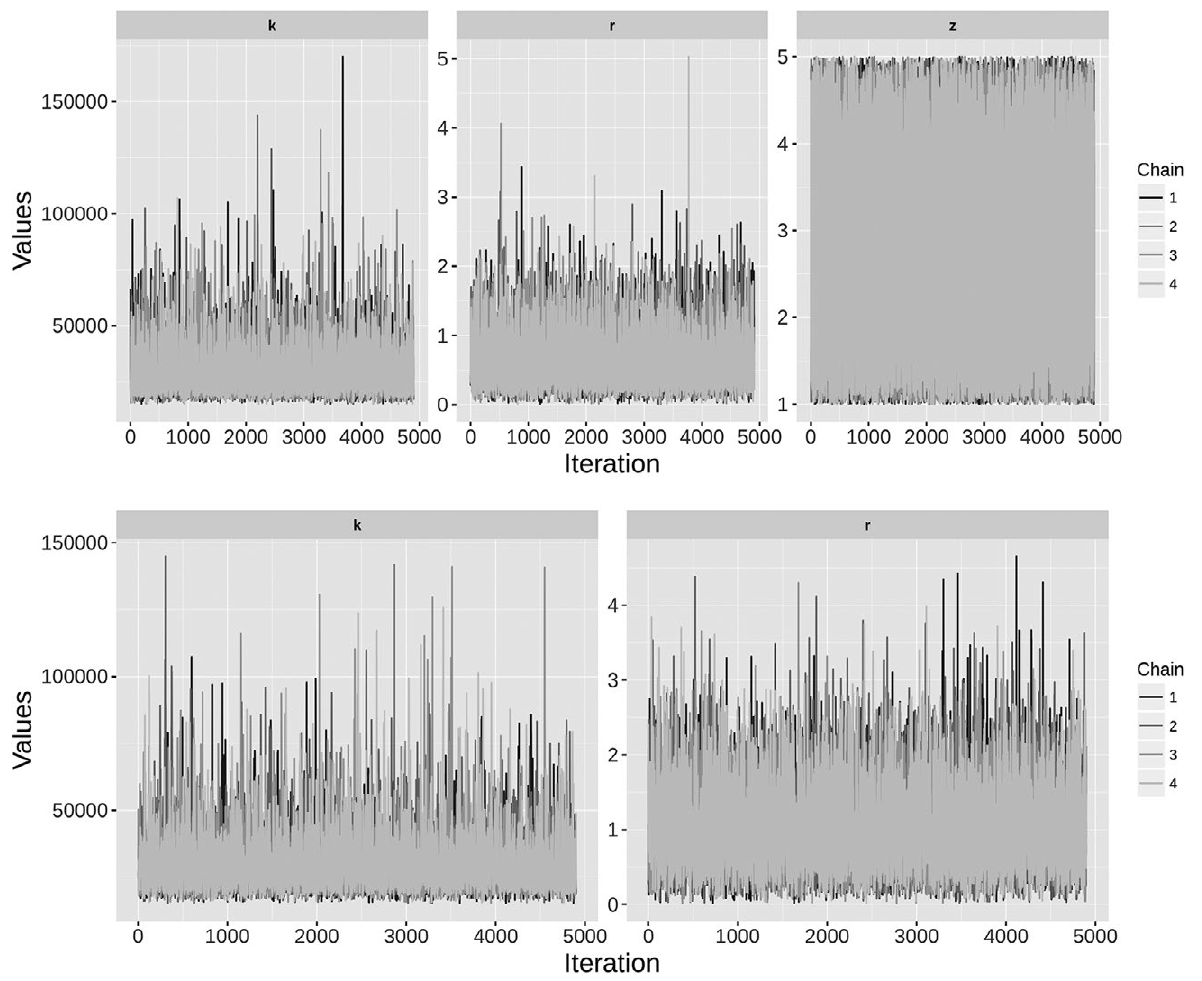
Fig. 3. – Trace plot diagnostic for assessing convergence of MCMC Chains for the two Bayesian state-space surplus production models. Top, Pella-Tomlinson model; bottom, Schaeffer